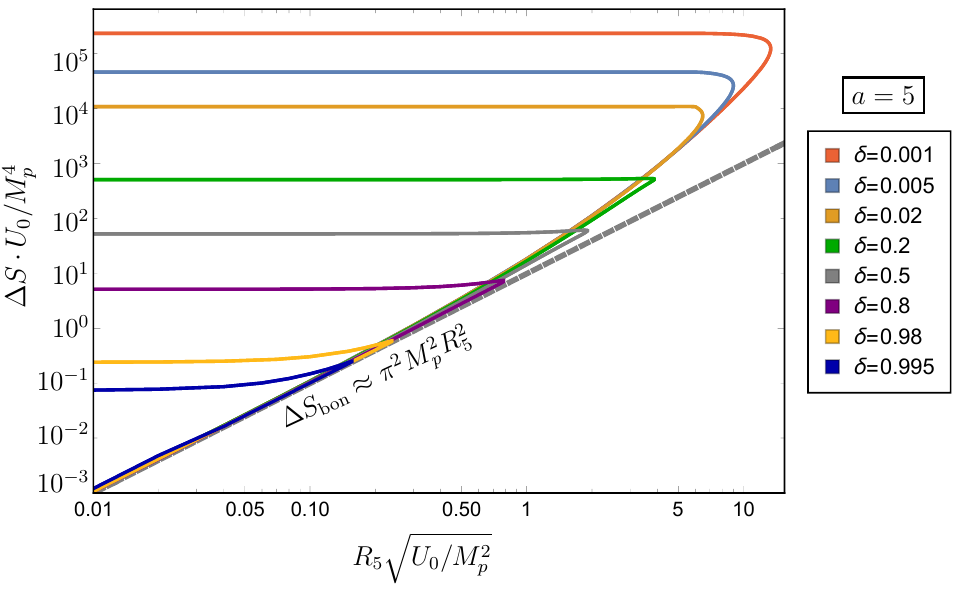
Figure 24: Action as function of R 5 Figure 12 . The de Sitter-subtracted Euclidean action ∆ S is shown in units of M 4 /U 0 as a p function of R , for a = 5 and various 0 < δ < 1 . The dashed gray line shows the ∆ S ≈ π 2 M 2 R 2 5 p 5 expectation from the small u 1 limit of the BON-FV solutions. It tracks the numerically- 0 (cid:28) computed action closely on this branch for all u 1 . This branch is always of lowest action and 0 (cid:28) determines the tunneling rate. On the BON-CDL branch the action approaches a constant, the ordinary CDL action ∆ S ≈ S , which is large compared to M 4 /U 0 for δ . 0 . 5 . For δ (cid:28) 1 , CDL p S CDL ≈ 24 π 2 M 4 / ( δ · U 0 ) , grows as 1 /δ . At larger values of u 0 , where π 2 M 2 R 2 ∼ ∆ S CDL , the p p 5 BON-FV and BON-CDL branches of bounce solutions meet. (This method of estimating the value of u = U at which the two branches meet becomes imprecise once u 1 , where π 2 M 2 2 /M 2 R 5 0 0 R 0 & p p 5 is no longer a good approximation to the BON-FV